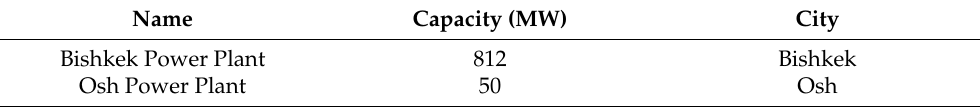
Table 4. Thermal power stations in